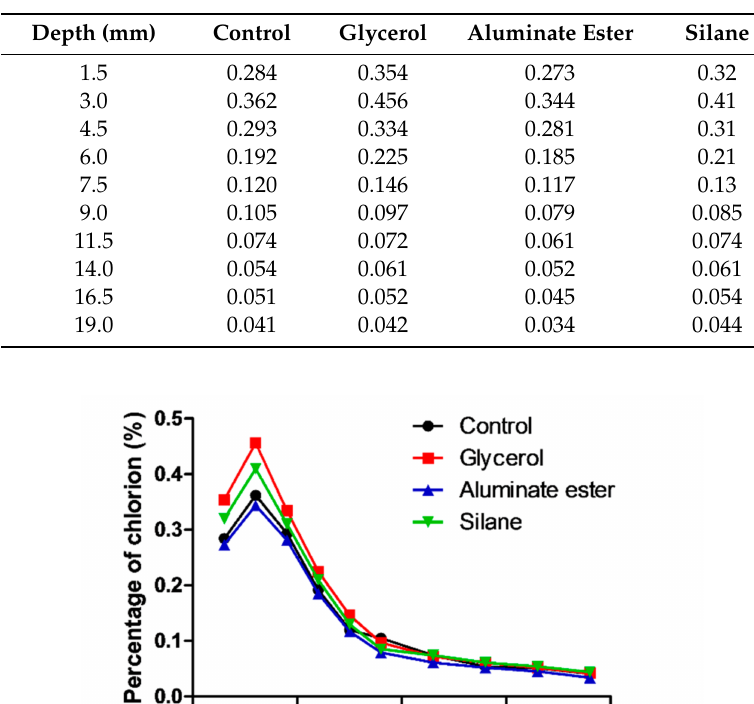
Table 6. Initial water absorption coe ffi cients of each mixtures g / (m 2 h 1 / 2 ).